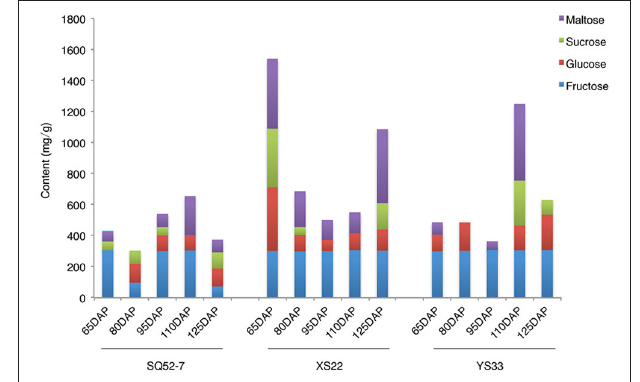
FIGURE 2 | Dynamic changes of sugar content during SR